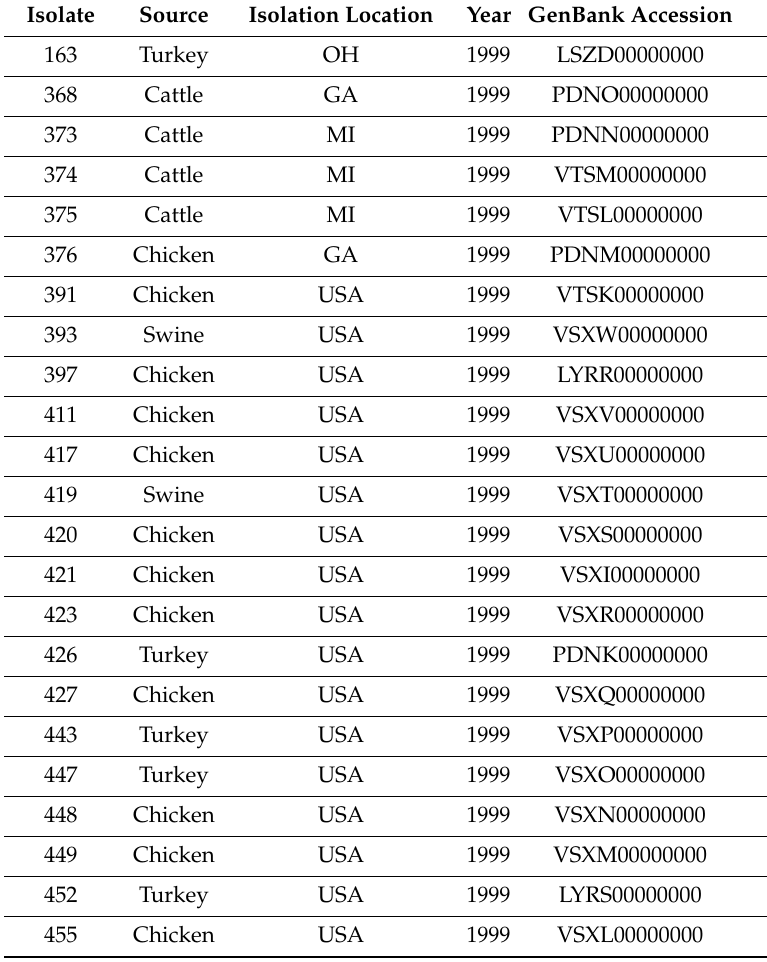
Table 1. Isolate information for 71 Salmonella enterica serovar